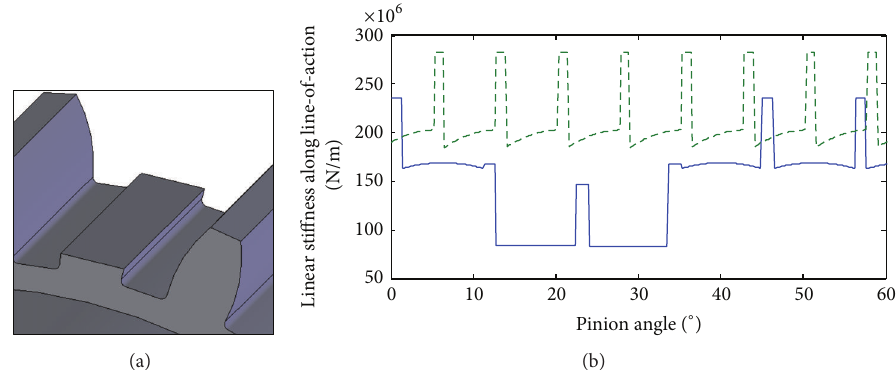
Figure 6: Missing tooth fault (a) model representation and (b) stiffness profile of first-stage gear.